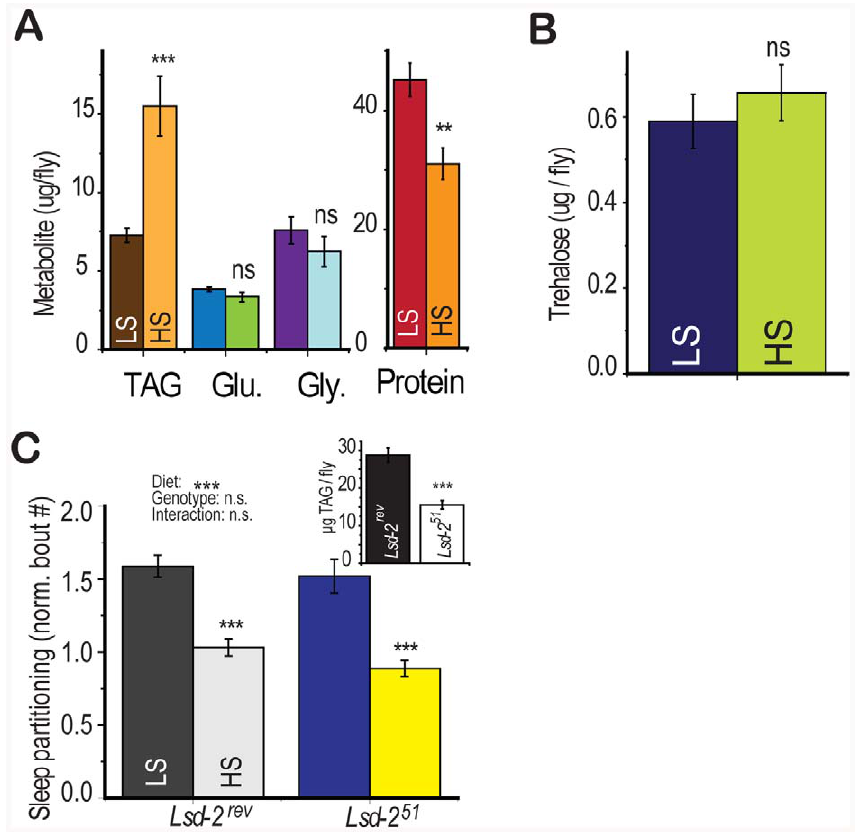
Figure 4. Diet-induced shift in energy storage is not sufficient to induce sleep partitioning. (A,B) A metabolite panel was tested in control ( yw ) flies that had previously been fed 2.5% (LS) or 30% (HS) sucrose on a 2.5% yeast base food for 6 days during activity monitoring. There was a significant change in triglyceride (TAG) and a smaller change in protein levels with no significant effect on glycogen (Gly), glucose (Glu), or trehalose. (C) Flies carrying the imprecise P-element excision deletion Lsd-2 51 had reduced triglyceride:protein levels relative to precise excision Lsd-2 rev controls (inset) but retained a significant sleep response to diet with no diet:genotype interaction (two-way ANOVA). Error bars represent mean + / 2 SEM for each group. ***=p , 0.001, **=p , 0.01,*=p , 0.05 for all statistical calculations. Error bars represent mean + / 2 SEM for each group. *** p , 0.001, ** p , 0.01,* p , 0.05 for all statistical calculations. Significance values for t-tests between dietary conditions are shown above each set of bars and significance values for two-way ANOVA are shown above the graph, where